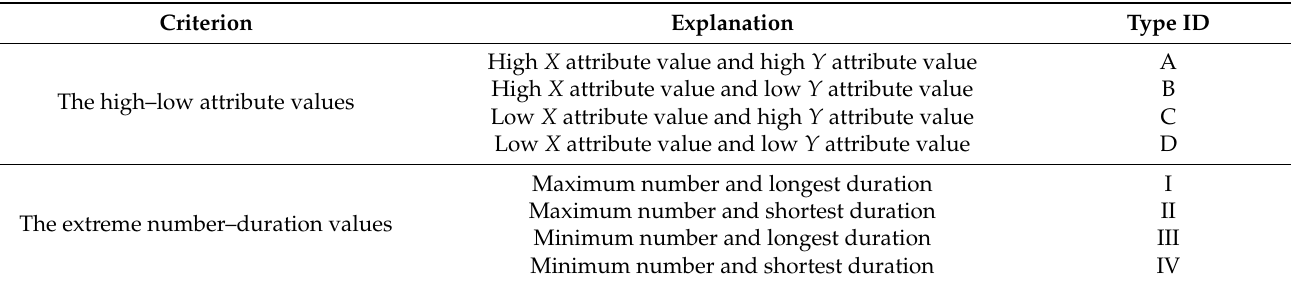
Table 2. The specific types of geographical flock